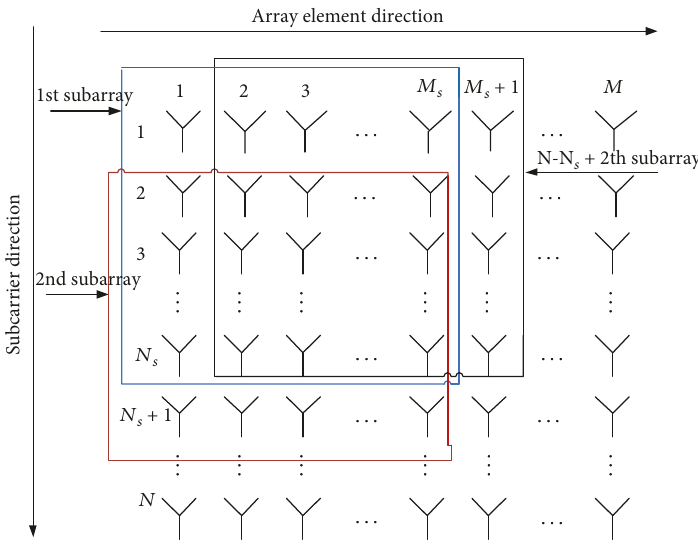
Figure 2: Virtual two-dimensional spatial smoothing